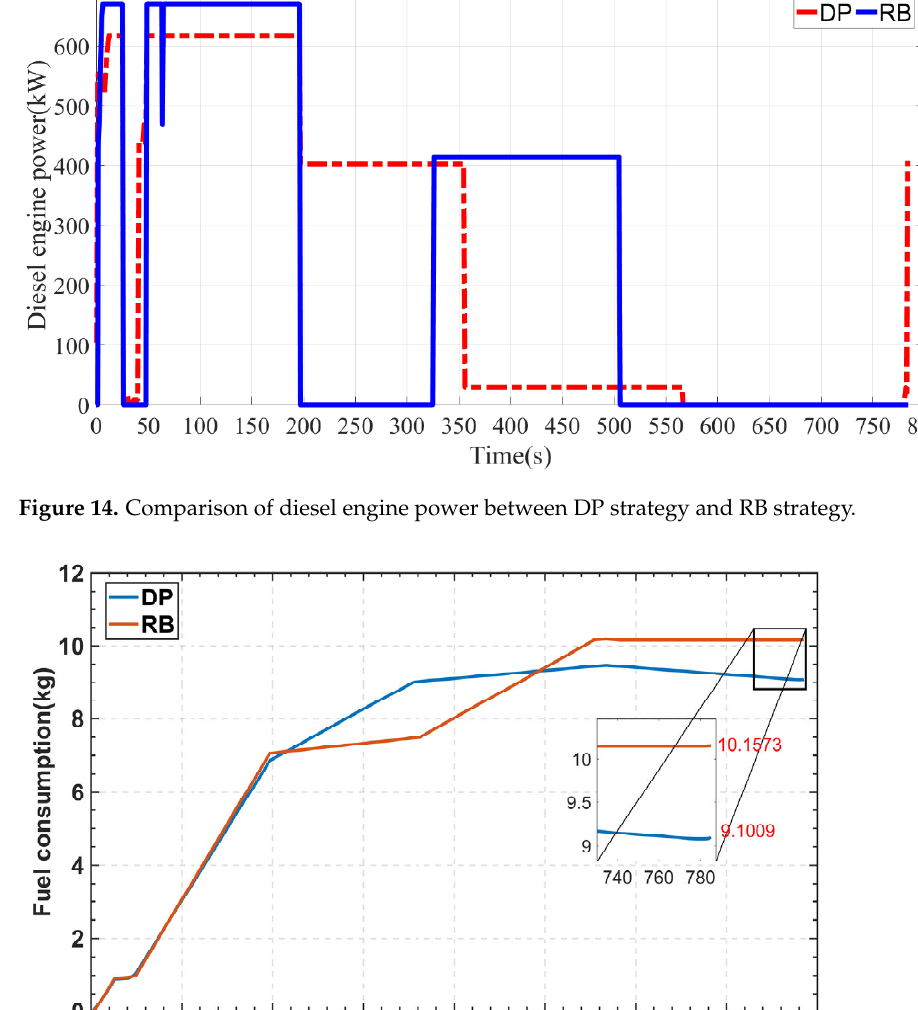
Figure 13. Power distribution diagram based on RB strategy.